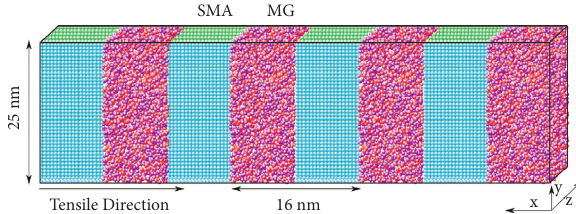
Figure 1: The schematic of laminated composite composed of MG and SMA